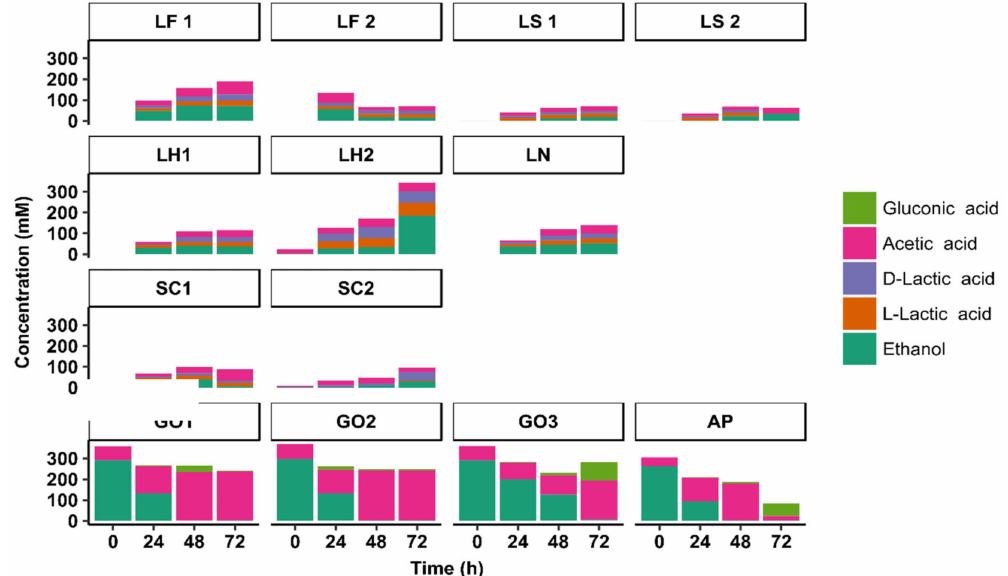
Figure 5. Concentrations of acetic acid, ethanol, gluconic acid, and lactic acid (D and L) during starter culture-initiated sourdough productions. The indication of the starter culture strains is as in Table 1. Low acetic acid concentrations ( < 6 mM) were found at the start of all sourdough